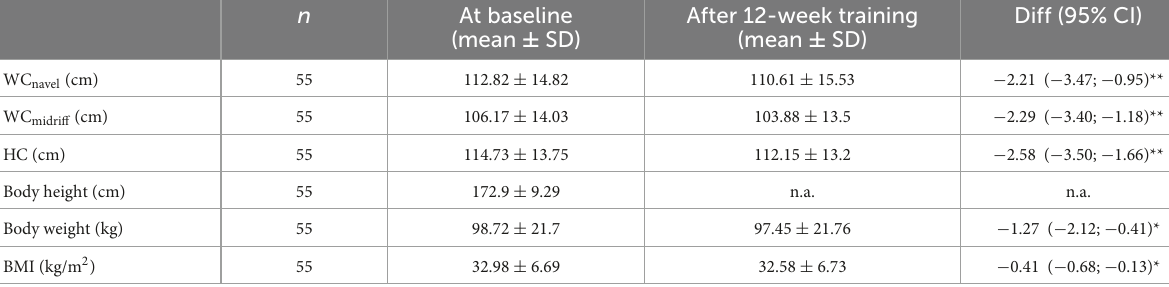
TABLE 2 Anthropometric parameters at baseline and after the training program.